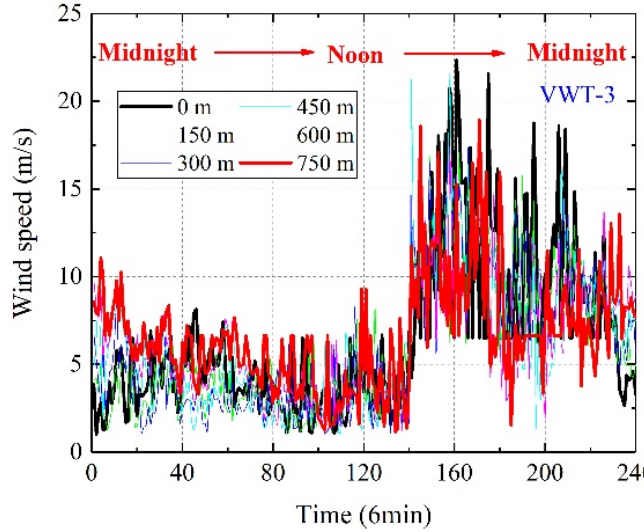
( d ) ( e ) Figure 7. Spatio-temporal distribution of wind speed, ( a ) VWT-1; ( b ) VWT-2; ( c ) VWT-3; ( d ) VWT- 4; ( e ) VWT-5. Time history of the wind speed is shown in Figure 8, with the height of the bridge deck taken as the starting point, from 0 m to 750 m and the interval is 150 m; thus, 6 specific heights are selected. The starting point on the time axis is selected as 0:0:0 at midnight every day, and the day is divided into 240 time periods with an interval of 6 min. Taking